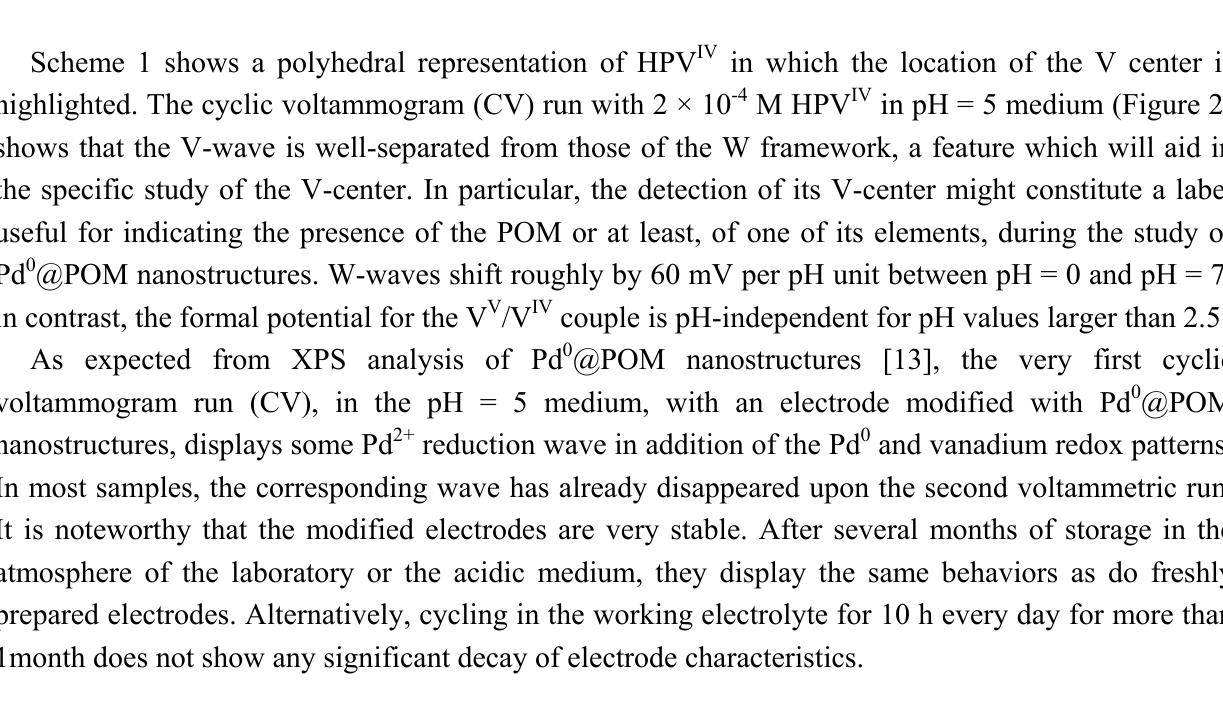
Scheme 1. Polyhedral representation of K